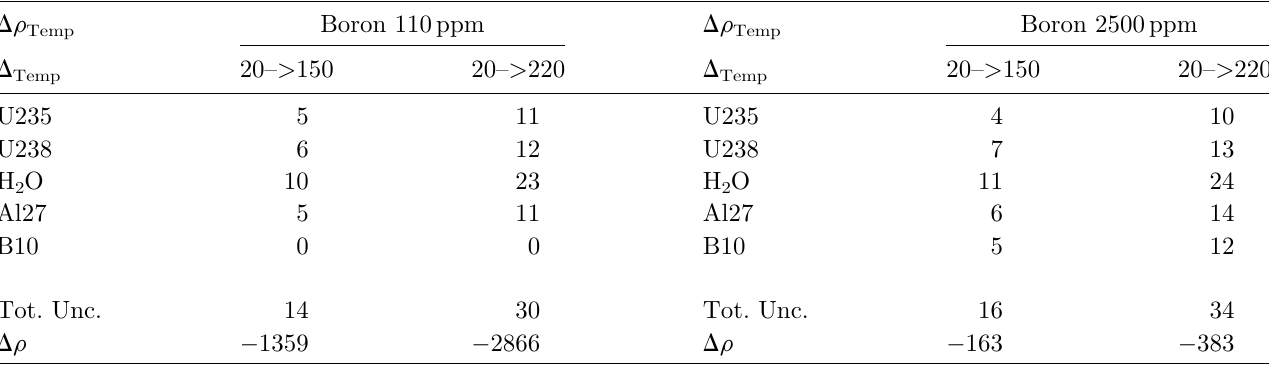
Table 5. Reactivity coef fi cients uncertainties, on the left, at 100 ppm of boron, on the right at 2500 ppm of boron for core temperature variations (pcm at 1 s ). D r Boron 110 ppm Boron 2500 Temp